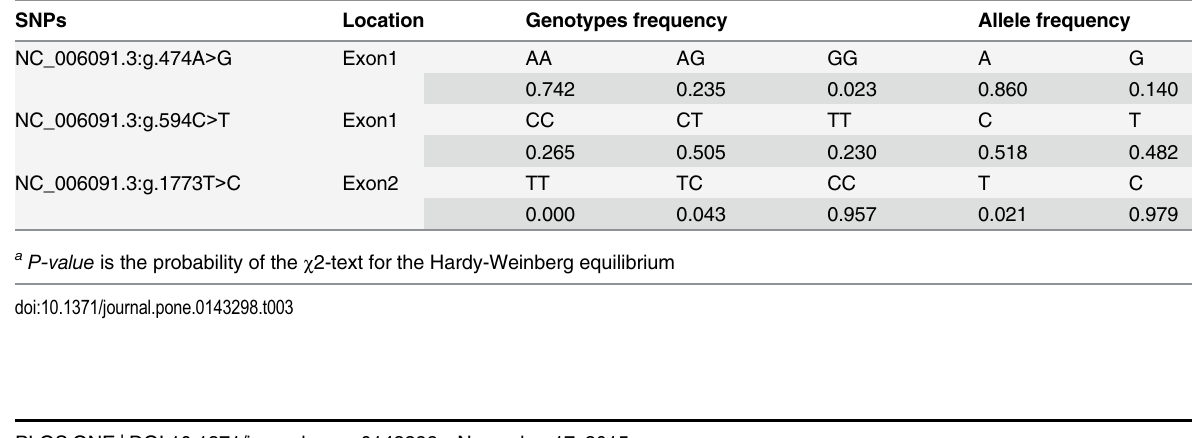
Table 3. Genotypes and alleles frequencies at site NC_006091.3: g.474A > G, NC_006091.3:g.594C > T and NC_006091.3:g.1773T > C of BMP15 gene.